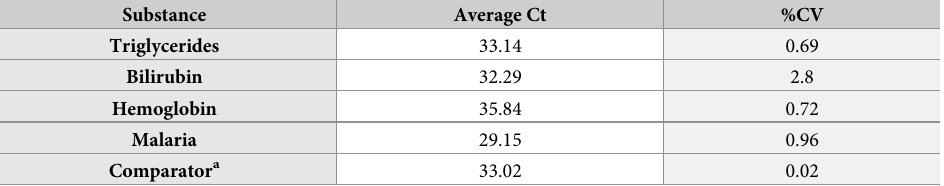
A table containing summarized performance data described here compared to the perfor- mance provided by altona Diagnostics to WHO for review, is available in a public document [23]. Table 5. The effects of potentially interfering substances on performance of RealStar Yellow Fever Virus RT-PCR kit 1.0. Substance